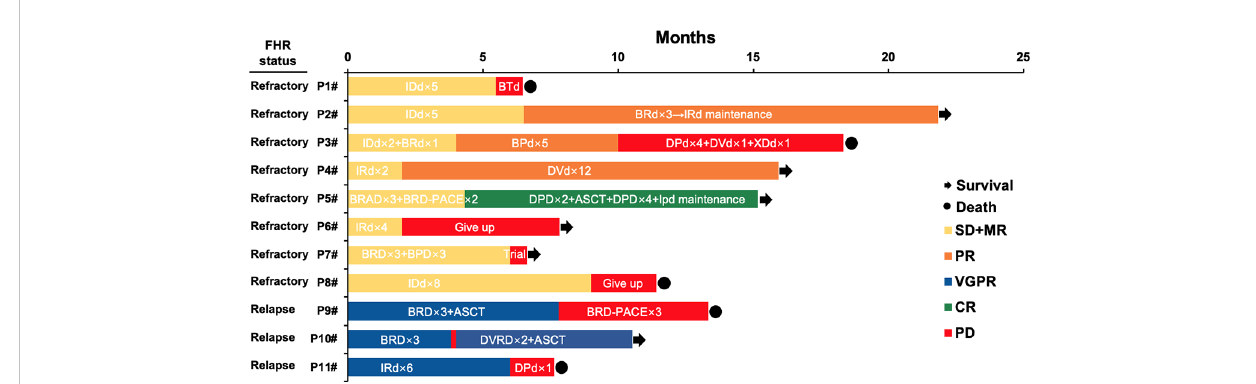
FIGURE 2 Treatment, response, and survival of eleven patients in the FHR group. IDd, Ixazomib- pegylated liposomal doxorubicin-dexamethasone; BTd, bortezomib- thalidomide-dexamethasone; BRD, bortezomib- lenalidomide-dexamethasone; BPD, bortezomib-